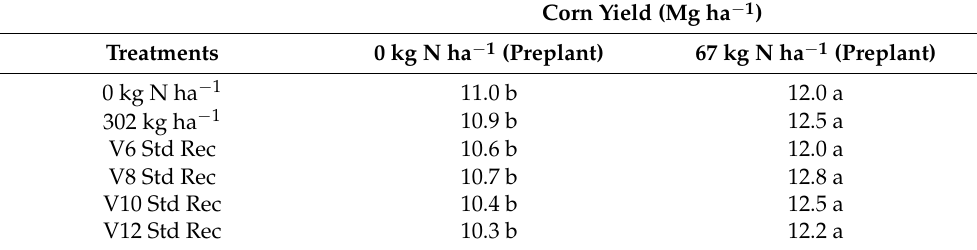
Table 6. Average corn yield for different treatments under two preplant N doses of 0 and 67 kg ha − 1 (ANOVA, Tukey’s HSD test). Different letters means the existence of a significant difference be- tween